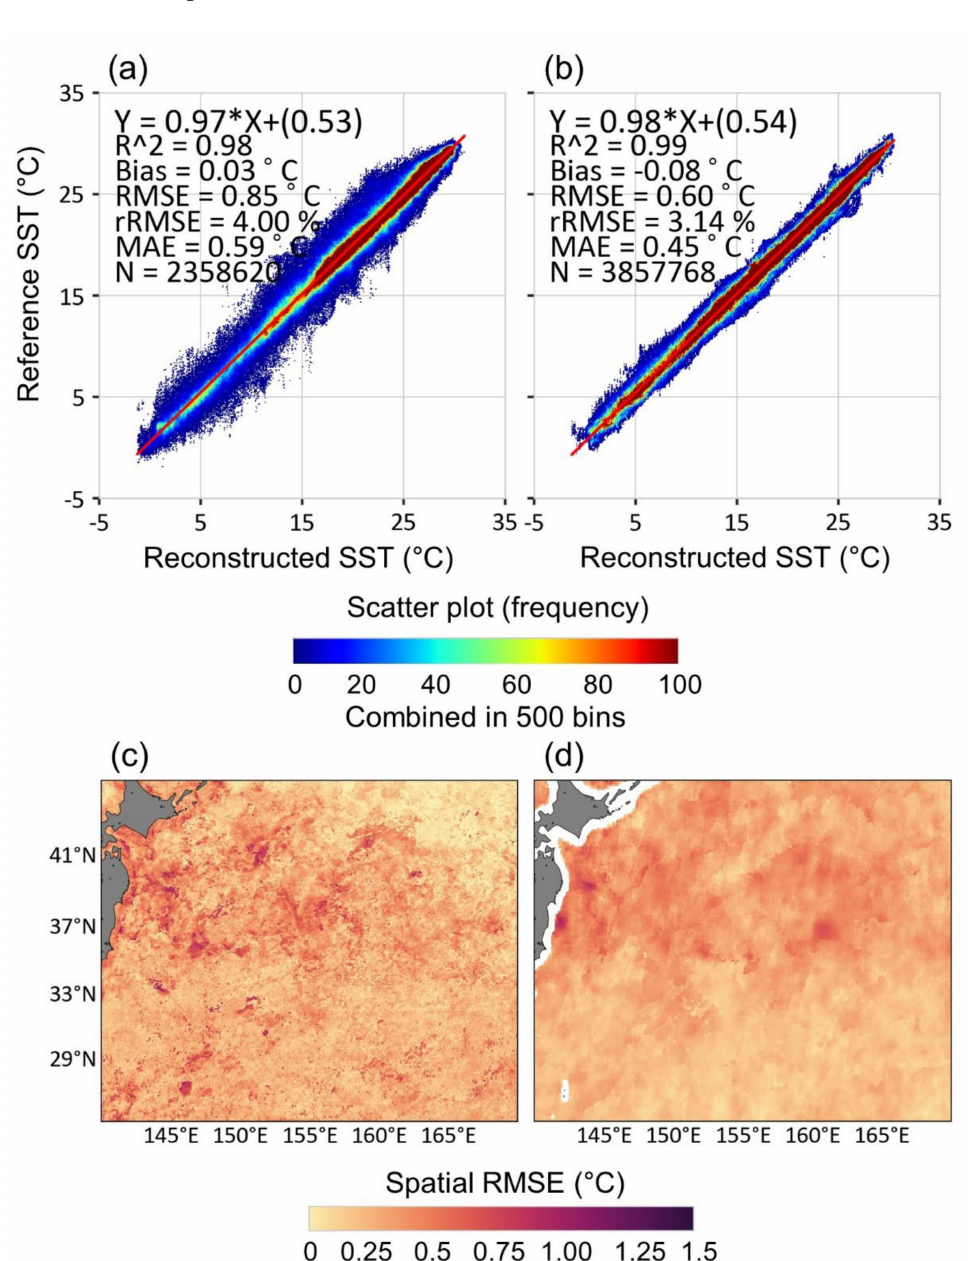
Figure 4. Validation accuracy of the reconstruction SSTs for the study area. ( a , b ) are the density scatterplots of the reconstruction models for MODIS and AMSR2, respectively. ( c , d ) are the spatial distribution of mean RMSE of the models for MODIS and AMSR2, respectively. The validation data were explained in Section